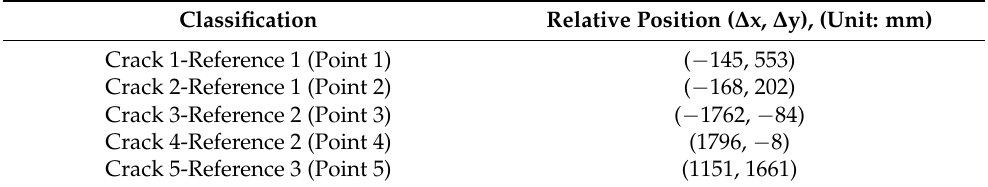
Table 3. Location of cracks relative to reference object. (Location from reference point to remote points of cracks).